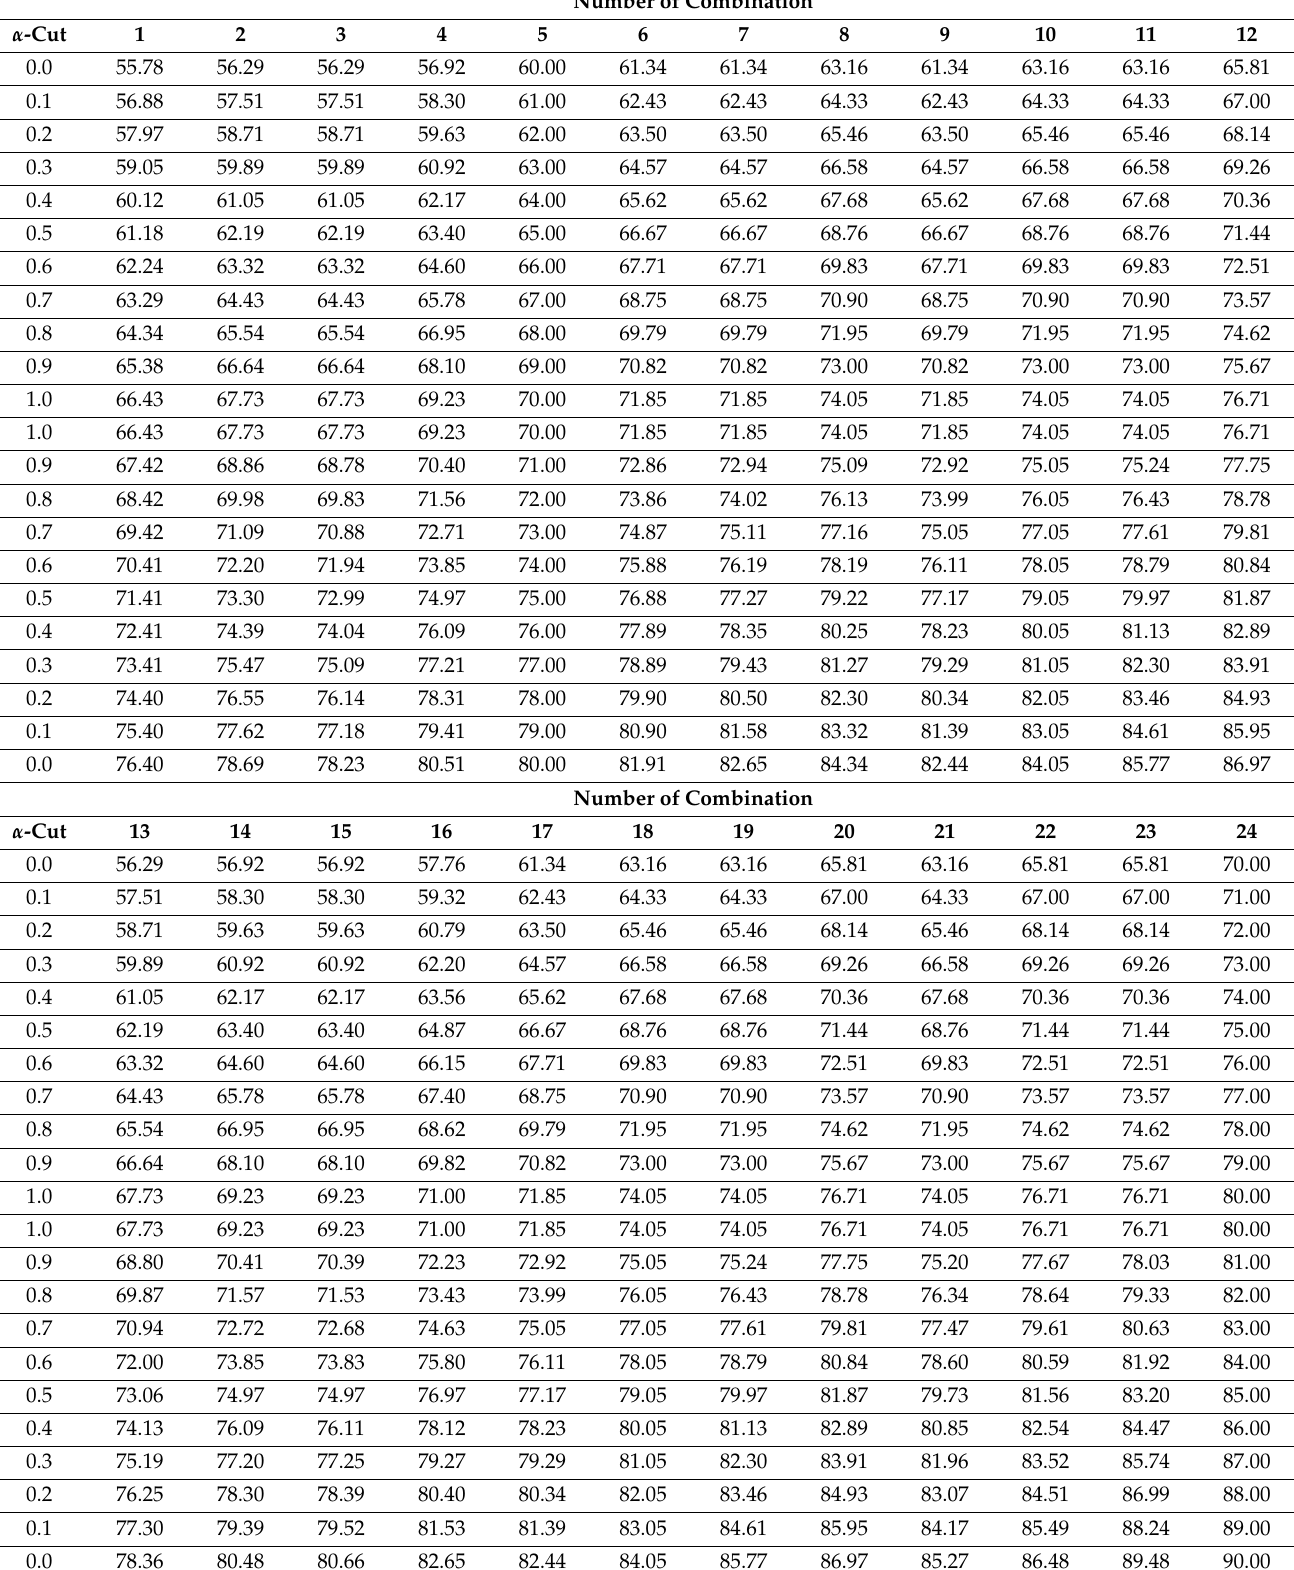
Table A4. The rating value of the superstructure component for all combinations (extended version of Table 8). Number of